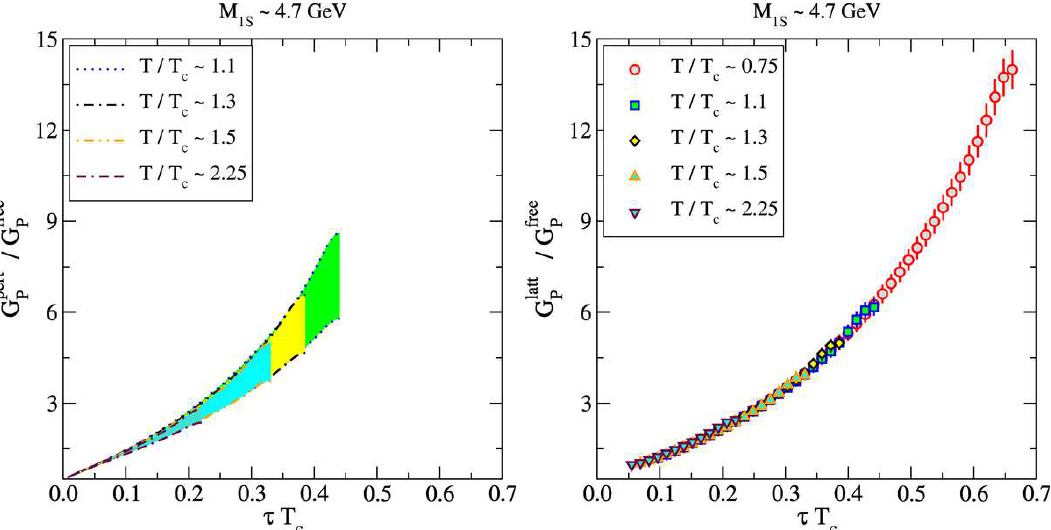
Figure 5 . Like figure 4 but for the bottomonium case. Here the perturbative uncertainty bands have been obtained by varying the central value m (¯ µ ) = 5 GeV by 2% in both directions. ref data shown in figures 4(right) and 5(right). We restrict ourselves to a rather